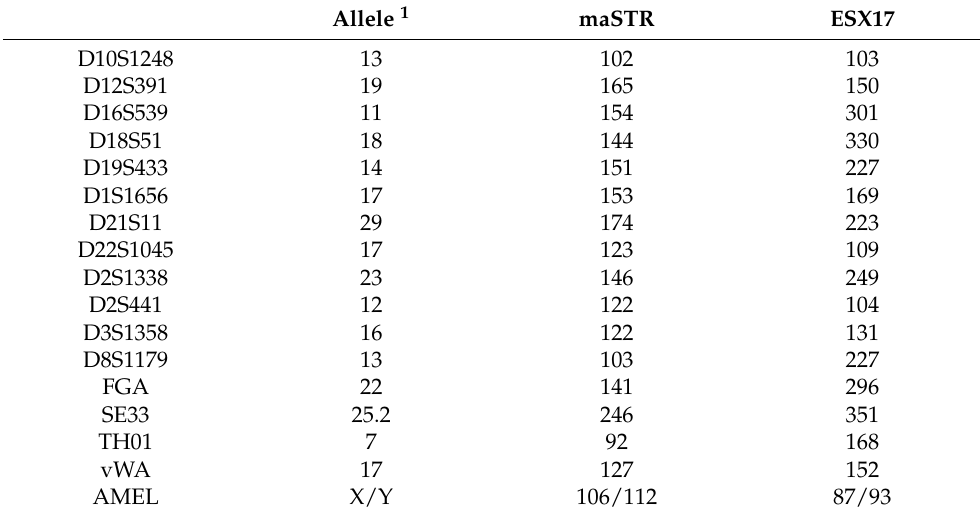
Table 1. Comparison of amplicon sizes of maSTR and PowerPlex ESX17 assay. Allele 1 maSTR